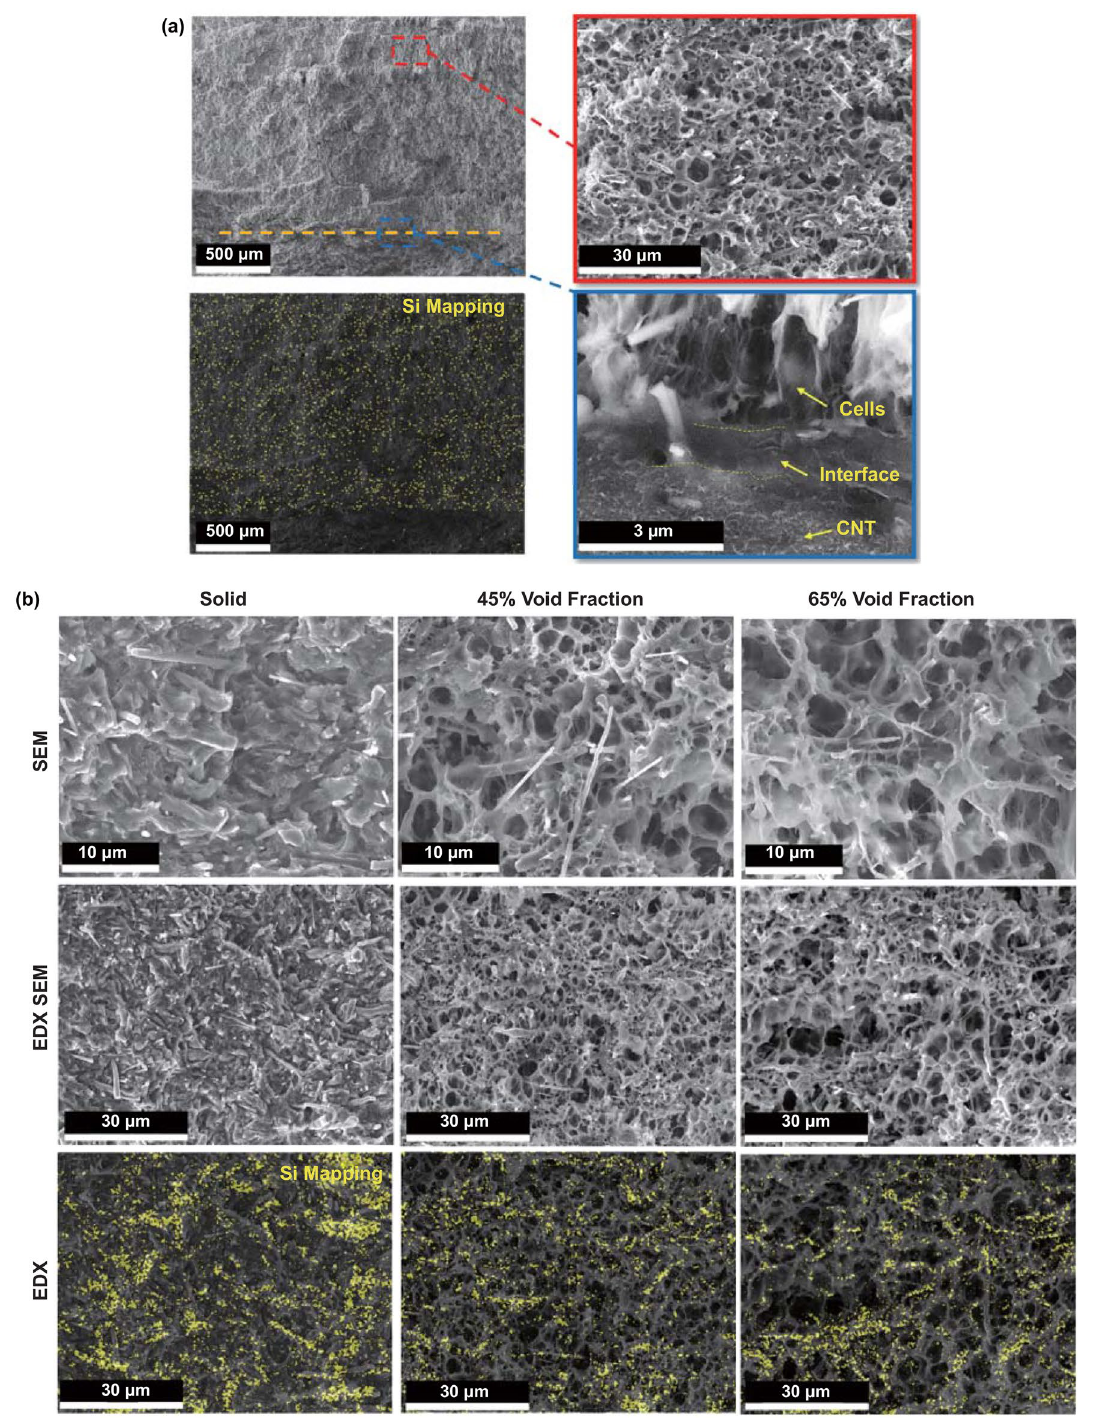
Fig. 3 Cross-sectional SEM images and Si EDX mapping of a the layered foam/film PVDF nanocomposite (upper layer VF: 45%); b upper foamed layer with a different void fraction (30% SiCnw@MXene7:1, VF: 0%, 45% and